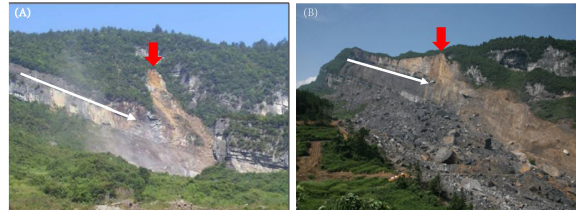
Fig. 4. Two photos over the Jiweishan rockslide, (a) taken 5h before sliding and (b) taken after the sliding. Red arrows indicate the same location, while white arrows indicate the down-slope directions in different photos.